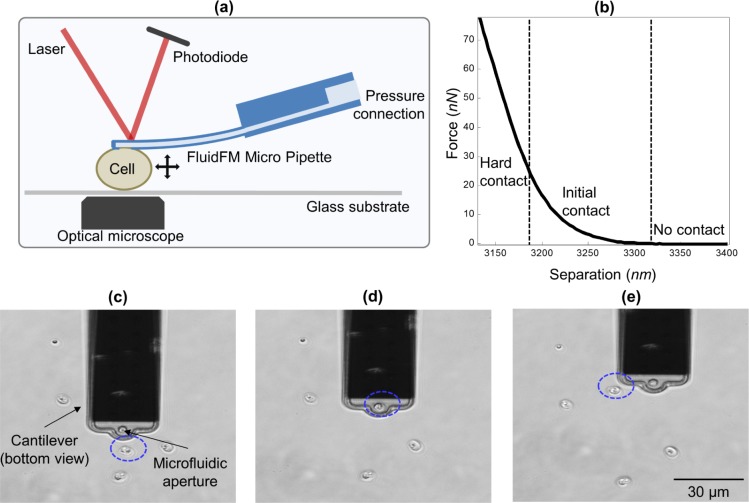
Oocyst measurement process (a) Schematic of FluidFM setup. (b) Typical force-distance curve showing zero (no contact), exponential (initial contact), and linear (hard contact) increase of force. (c-e) An oocyst (indicated by dashed blue oval) is selected, measured and released.